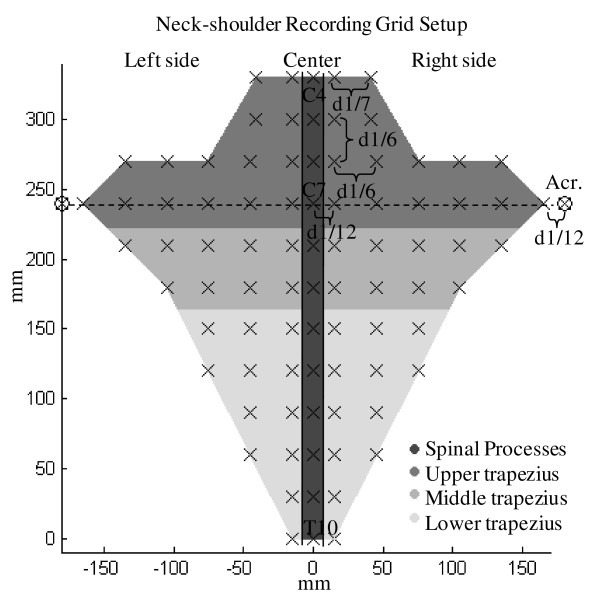
Schematic representation of the neck-shoulder PPT recording grid (84 points). All distances between adjacent points were based on an anthropometric measure (the distance (d1) between the seventh cervical vertebrae (C7) and acromion (Acr.)). The cervico-thoracic region was divided by location (left side, center and right side) and trapezius subdivisions (upper, middle, lower trapezius).